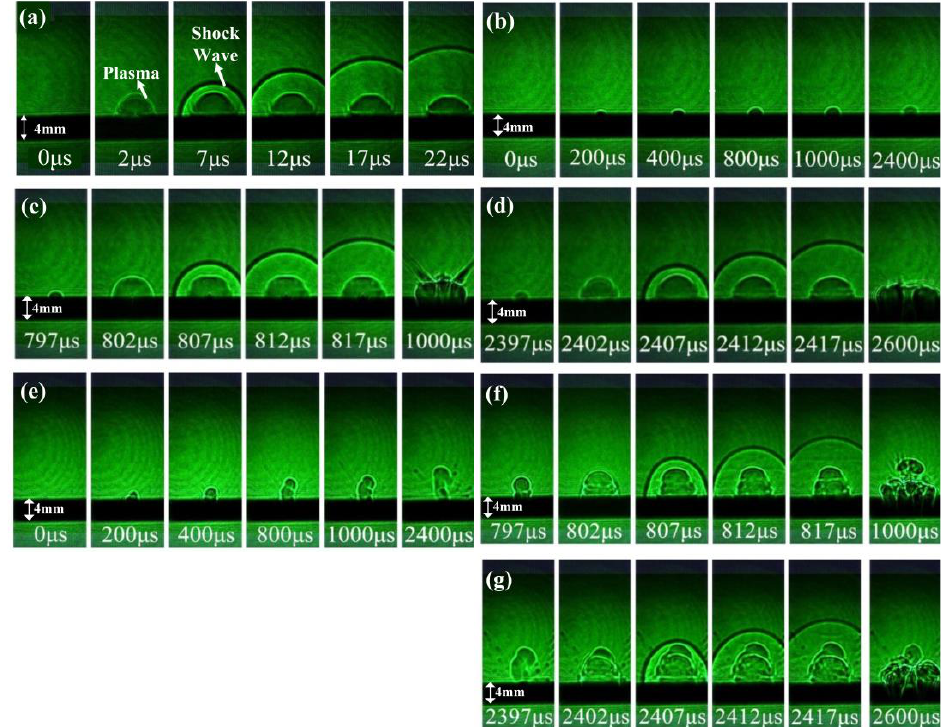
Figure 2. The propagating morphology of plasma and shock wave induced by an ns laser, ms laser, and ms-ns CPL, respectively. ( a ) Result of the single ns laser, D ns = 12 J/cm 2 . ( b ) Result of the single ms laser, D ms = 226.13 J/cm 2 . ( c ) Result of ms-ns CPL, D ms = 226.13 J/cm 2 , ∆ t = 0.8 ms. ( d ) Result of ms-ns CPL, D ms = 226.13 J/cm 2 , ∆ t = 2.4 ms. ( e ) Result of a single ms laser, D ms = 301 J/cm 2 . ( f ) Result of ms-ns CPL, D ms = 301 J/cm 2 , △ t=0.8 ms. ( g ) Result of ms-ns CPL, D ms = 301 J/cm 2 , △ t=2.4 ms.